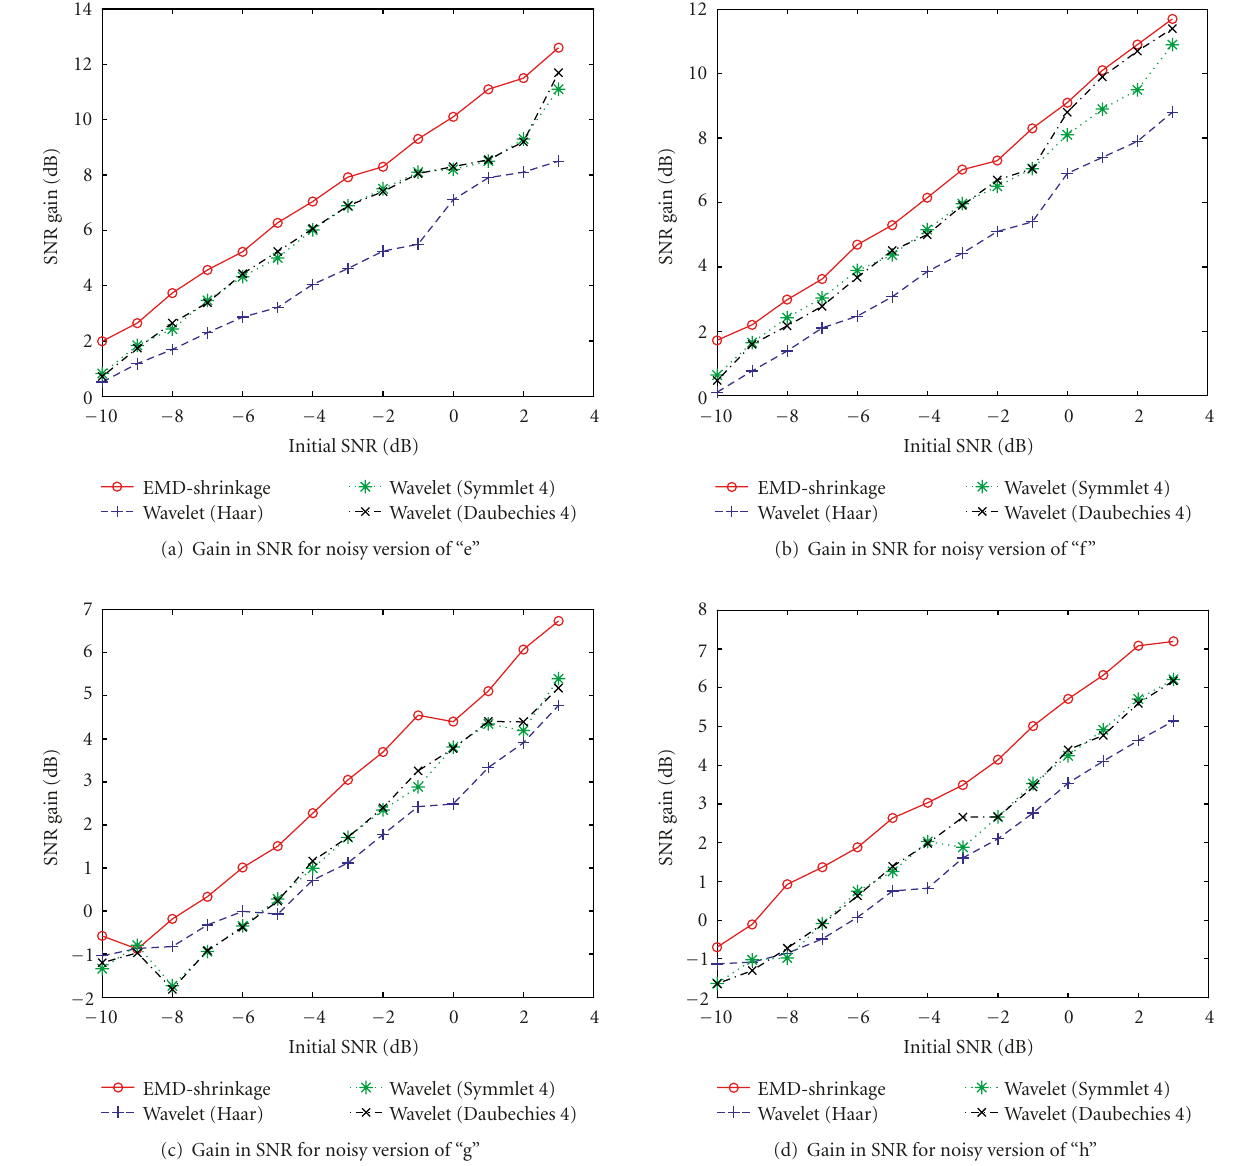
Figure 8: Final SNR values obtained for di ff erent initial noise levels of signals “e”, “f”, “g”, and “h”. The results are the average of 100 instances signal. It’s reported for EMD-shrinkage and for three di ff erent wavelets (Haar, Symmlet 4, Daubechies